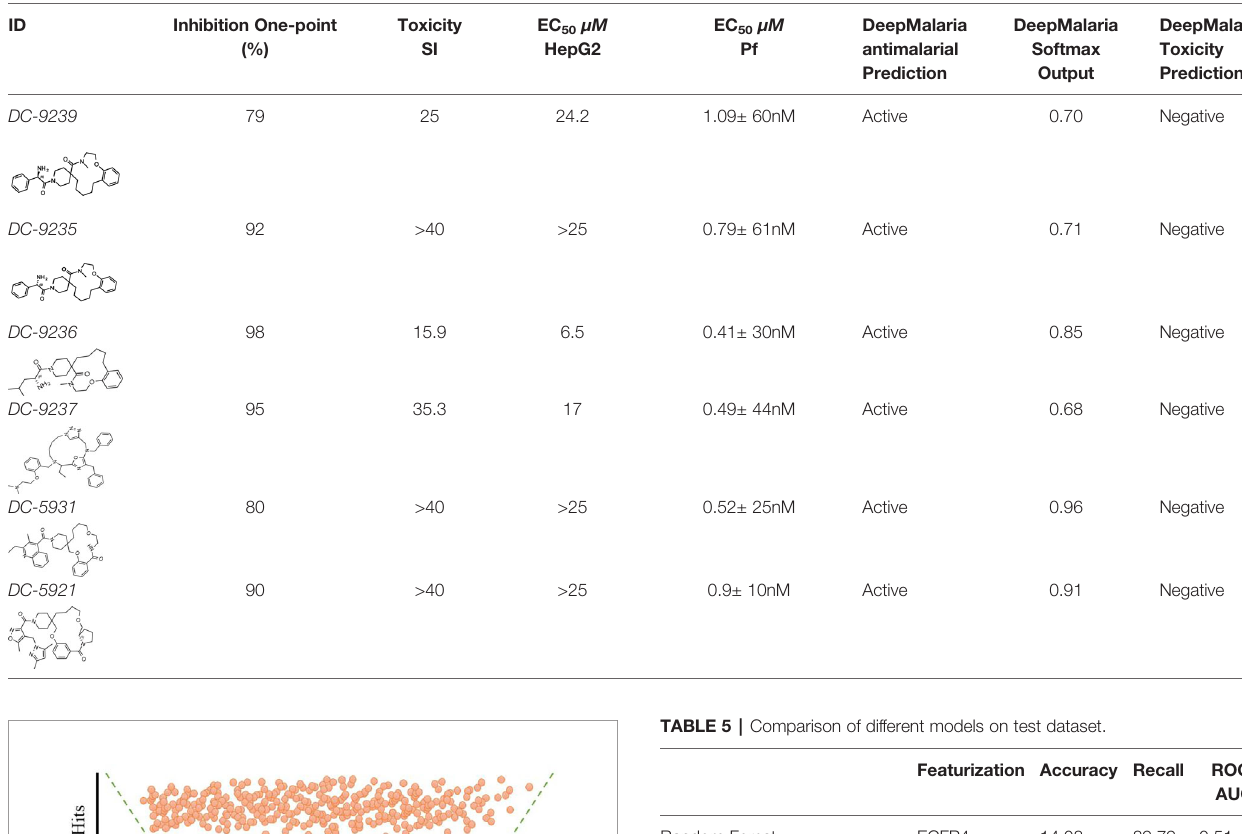
TABLE 4 | In vitro and in silico results of the compound with Nano-molar activity.